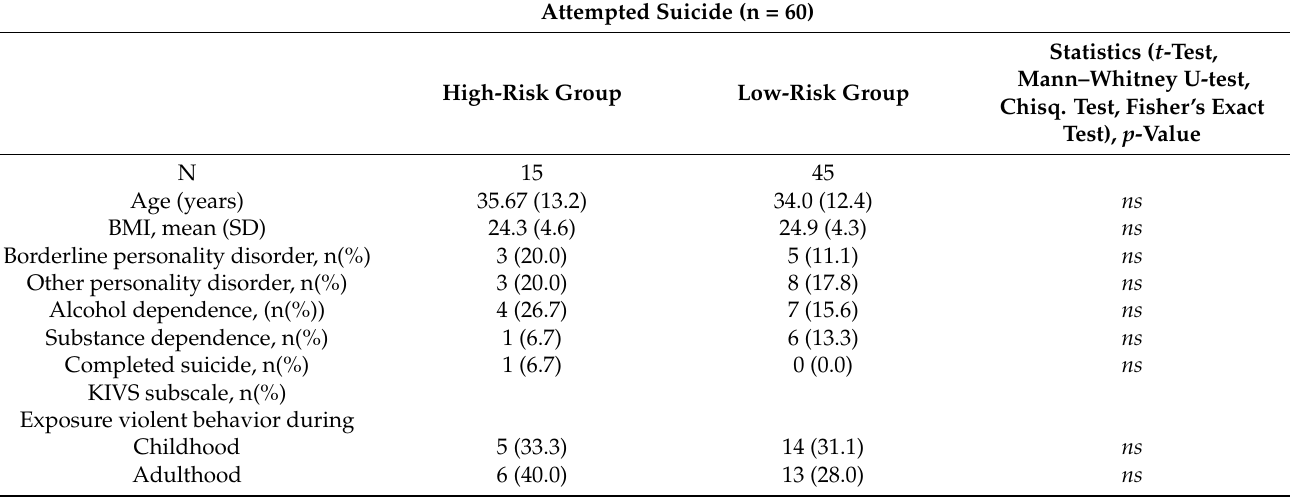
Table 4. Characteristics of subjects (Suicide